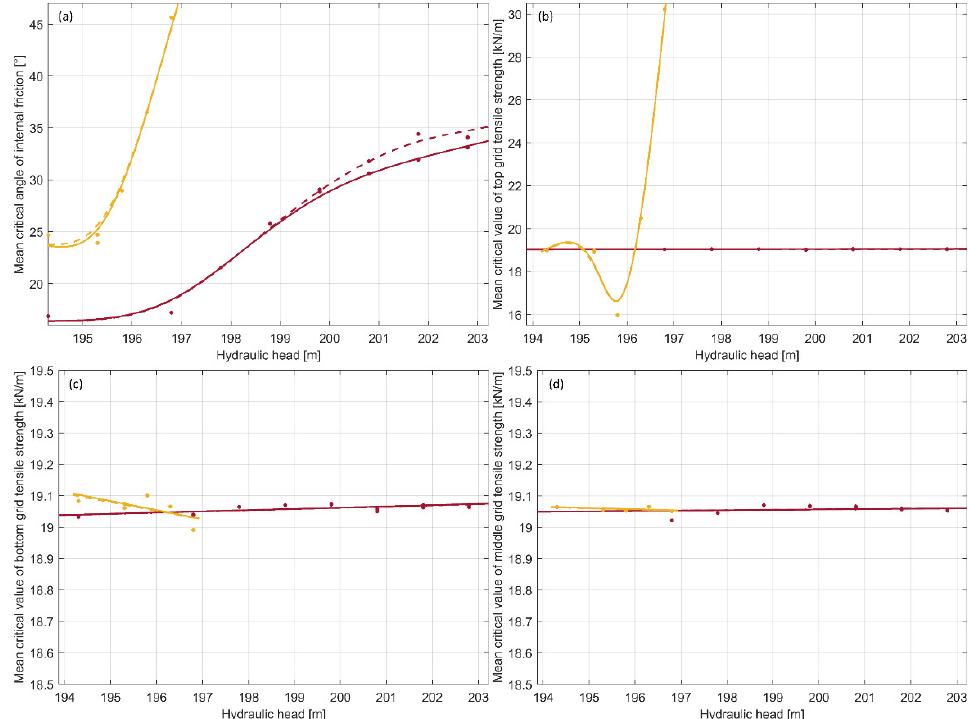
Figure 15. Critical values of random variables for various water levels; ( a ) friction angle (top left), ( b ) top grid (top right), ( c ) middle grid (bottom left), ( d ) bottom grid (bottom right); dark lines represent LSF10, light lines LSF15, full lines shallow sliding, and dashed lines deep sliding.